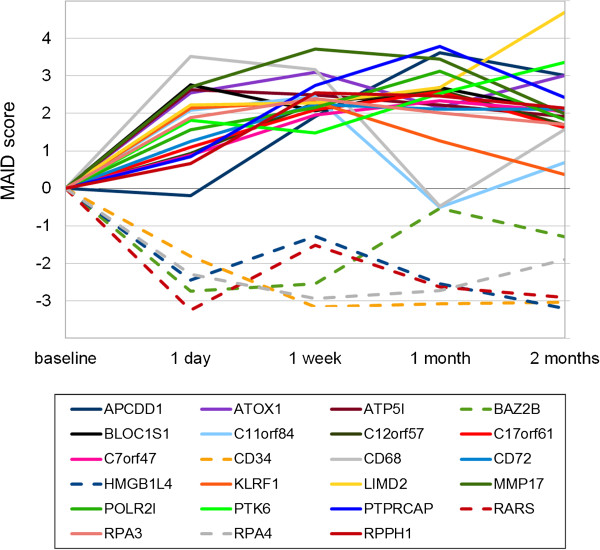
Dynamics of 23 genes consistently modulated in expression during glatiramer acetate (GA) therapy. A subset of the 463 filtered genes appeared repeatedly as differentially expressed in consecutive time point comparisons. The graph shows the mean mRNA expression dynamics of 23 genes that were repeatedly found expressed at significantly higher or lower levels across at least two different time points compared to the pre-treatment levels. There were 18 up-regulated genes and 5 down-regulated genes (CD34, RPA4, HMGB1L4, RARS and BAZ2B). The MAID-score, a fold-change variant that is calculated from the data of all patients, is represented on the y-axis and the time points are represented on the x-axis.